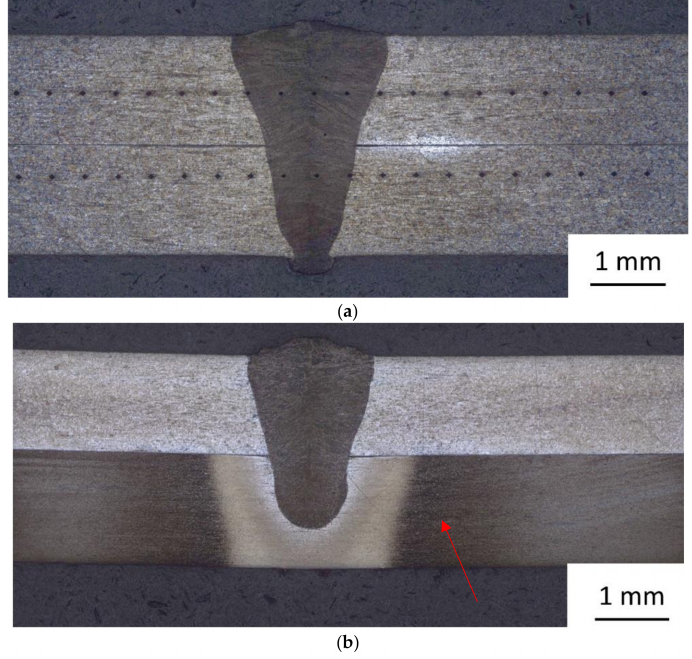
Figure 5. Macrostructure of welds with different combinations of sheets and laser power: ( a ) T15-82a + T15-82a welded with 1920 W; and, ( b ) T15-82a + T15-82c welded with 1650 W with heat affected zone marked with